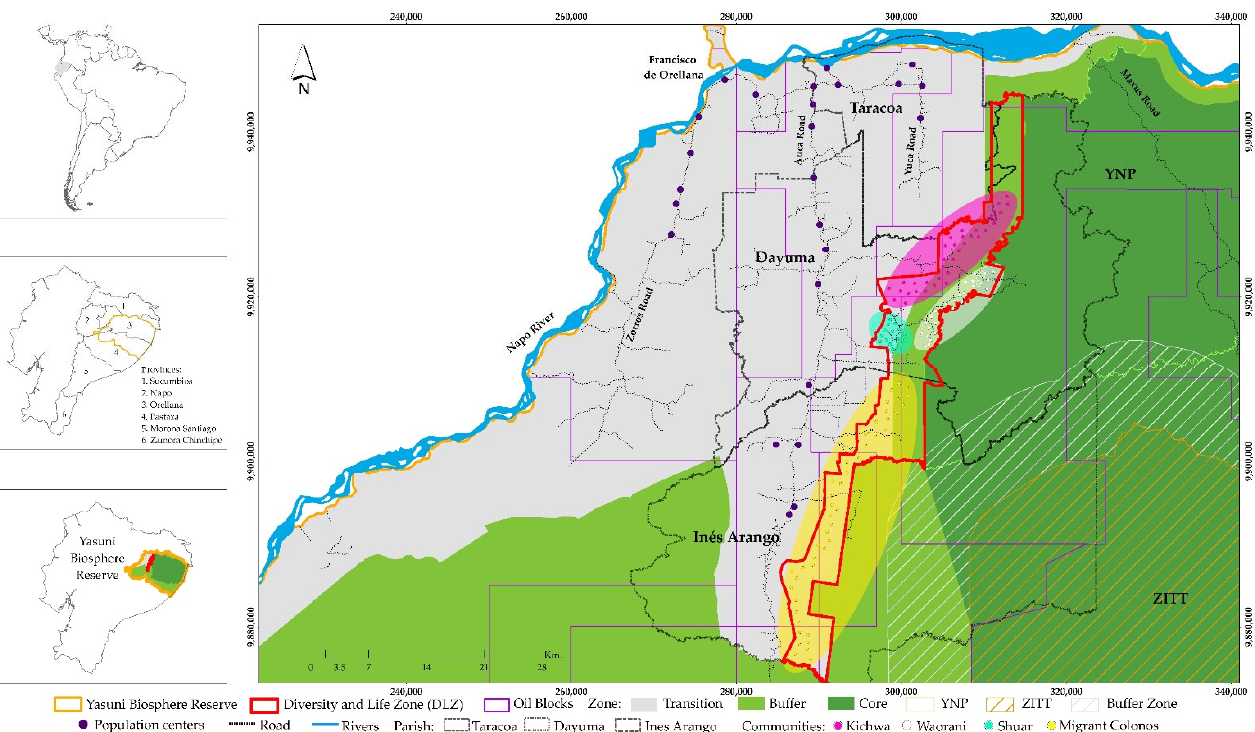
Figure 1. Diversity and Life Zone located in the parishes of Taracoa, Dayuma, and Inés Arango, Yasuní Biosphere Reserve of the Ecuadorian Amazon Region.